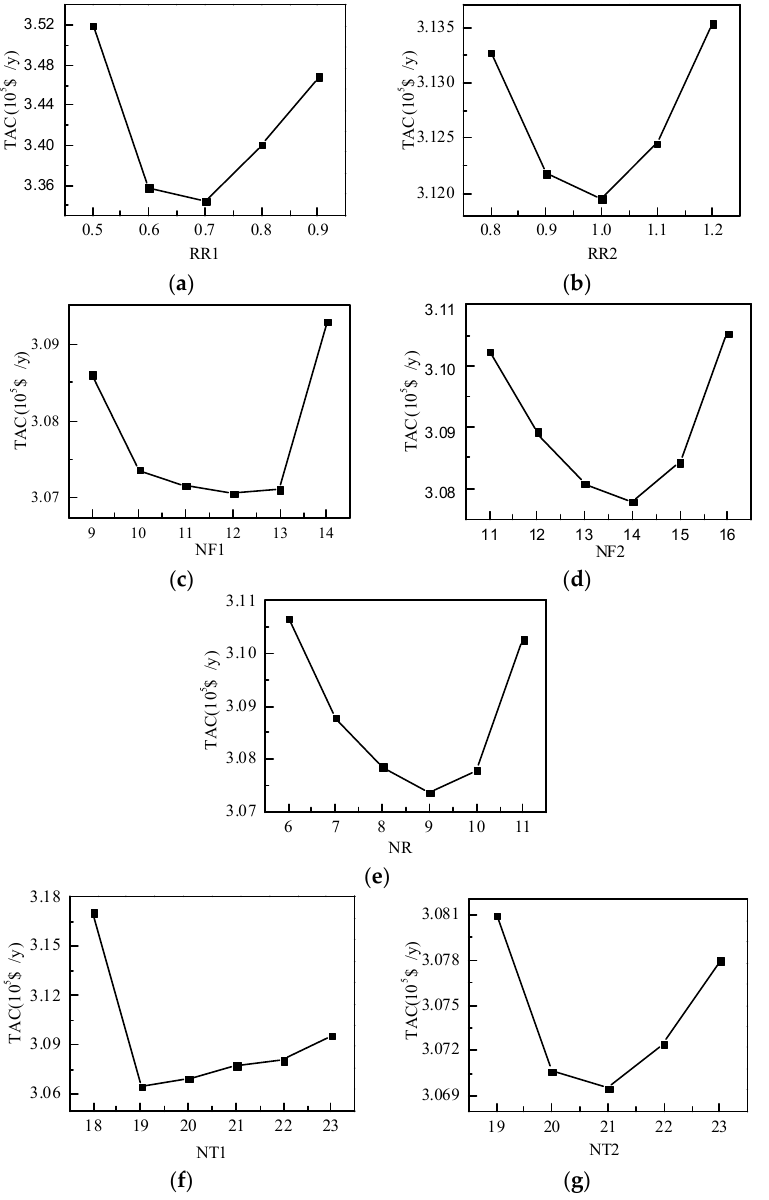
Figure 4. The effect of the seven variables on total annual cost (TAC) in the partial HIPSD process: ( a ) RR1, ( b ) RR2, ( c ) NF1, ( d ) NF2, ( e ) NR, ( f ) NT1, ( g ) NT2.